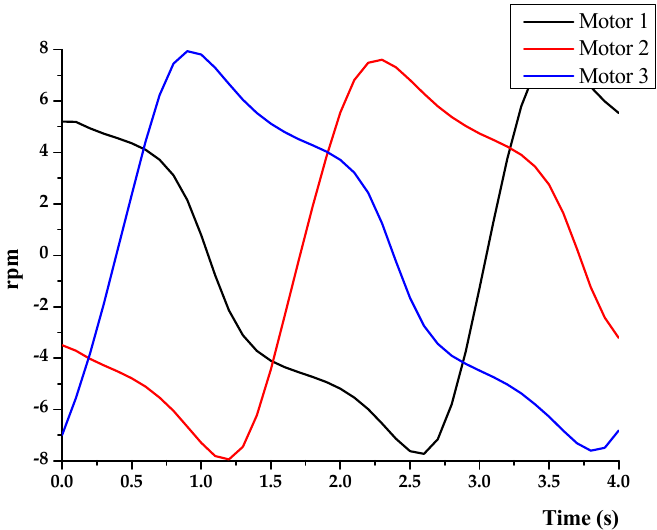
Figure 20. Motor output speed graph, the maximum velocity was about 7.8 rpm. Moreover, in order to confirm the error between simulation and test, the roll and pitch motion path were input into the platform and performed for the actual measurement. In roll motion, the maximum angular velocity of the platform simulation was 15.71 rad/s, and the maximum angular velocity of the actual measurement was 14.55 rad/s. The comparison of the velocity for the simulation and the actual measurement is shown in Figure 21a. The maximum angular acceleration of the simulation was 24.67 rad/s 2 , and the maximum angular acceleration of the actual measurement was 22.8 rad/s 2 , as shown in Figure 21b.